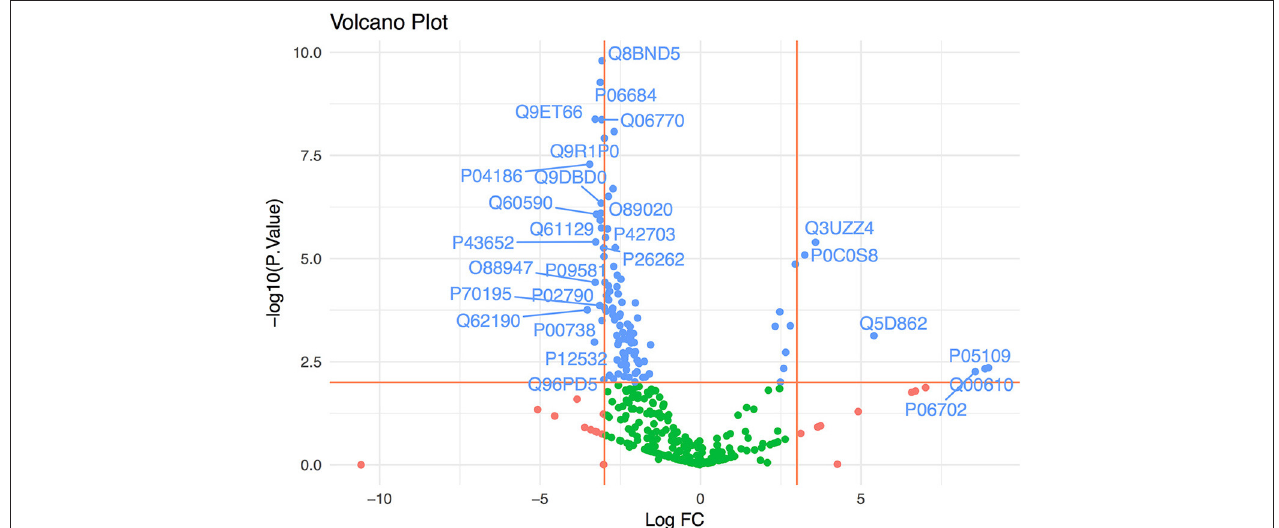
FIGURE 2 | Exosome-enriched fractions (ExEFs) are depleted of contaminating plasma proteins. The log fold-change (FC) in abundance of human proteins detected by LC-MS/MS in the ExEFs and MvEFs of P. vivax infected FRG huHep mice from EI1 were compared. The horizontal line represents p = 0.01 and vertical lines correspond to a 3-log fold increase or decrease in abundance. Green points represent p > 0.01 & FC between [ − 3,3], blue points represent p < 0.01 and red points represent p > 0.01 & FC > 3 or FC < − 3. Proteins with p < 0.01 and FC > 3 or FC < -3 are labeled. Supporting data are shown in Data Sheet S3